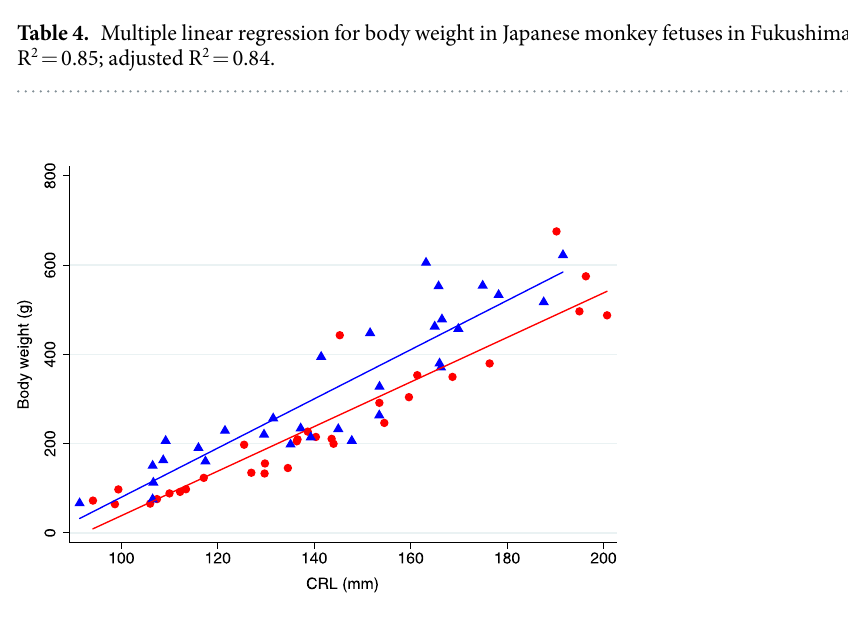
Figure 1. Body weight (g) as a function of CRL (mm) in Japanese monkey fetuses pre- and post-NNP disaster (n = 62). The figure shows regressions between body weight and CRL in pre- and post-disaster groups. Blue triangles were pre-disaster monkey fetuses with the blue line representing the fitted values (n = 31); R 2 = 0.86. Red circles were post-disaster monkey fetuses with the red line representing the fitted values (n = 31); R 2 = 0.82.